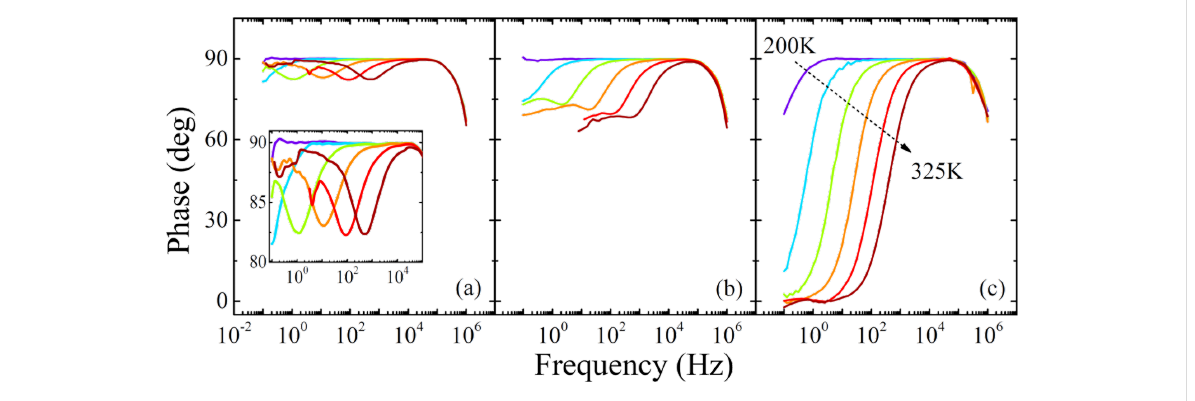
Figure 2: Impedance phase frequency spectra recorded in the temperature range from 200 to 325 K with the step of 25 K at voltage biases of (a) 1 V, (b) 2 V, and (c) 4 V. Inset depicts detail view of the phase spectra.